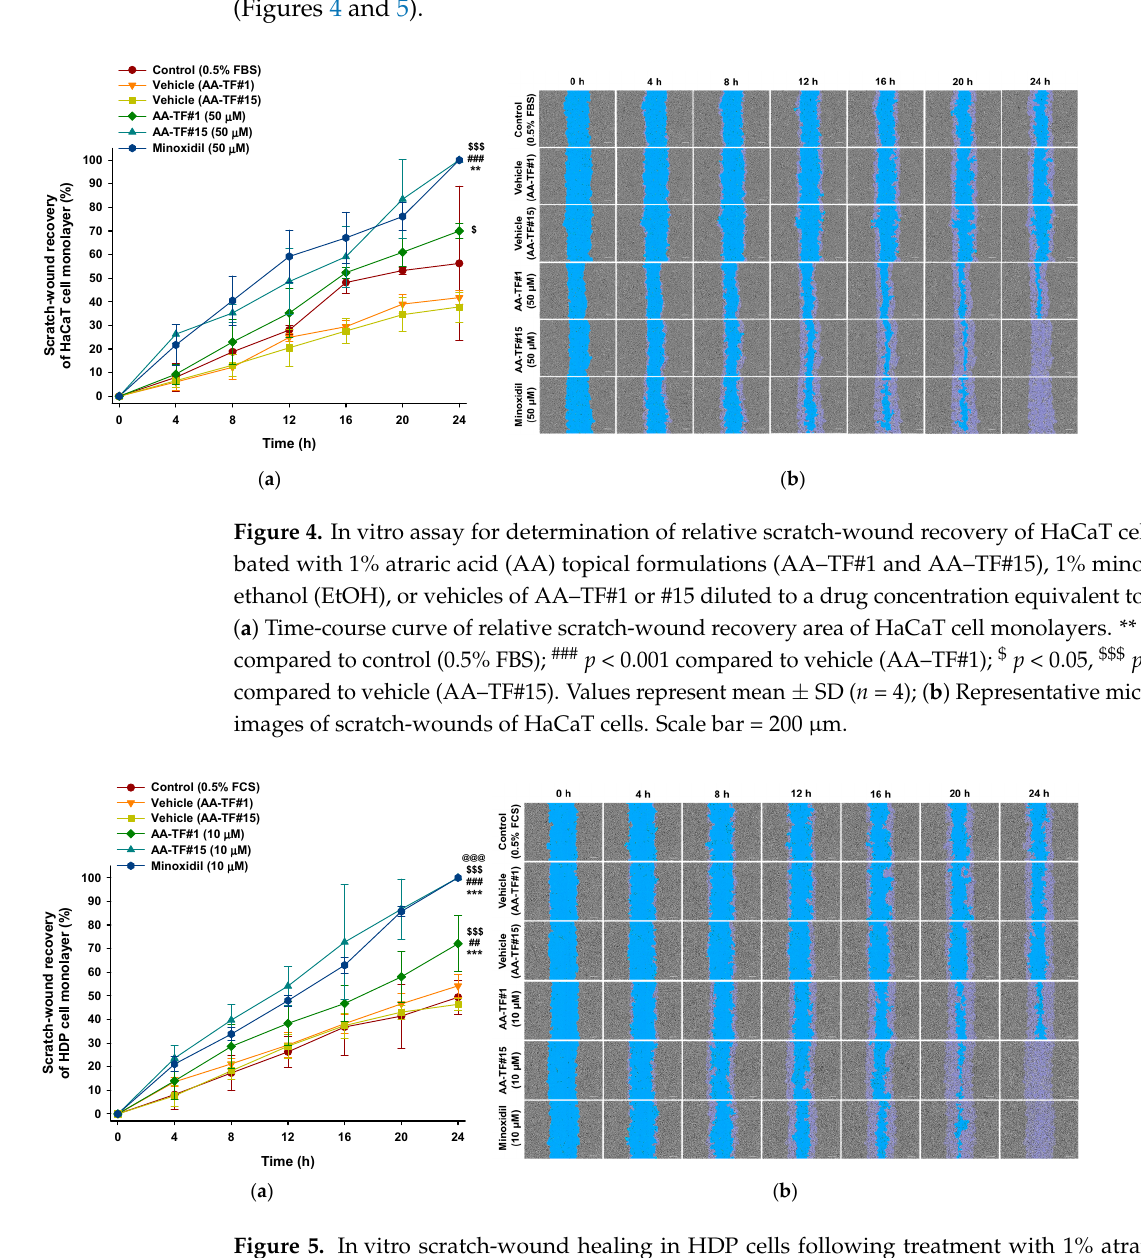
Figure 5. In vitro scratch-wound healing in HDP cells following treatment with 1% atraric acid (AA) topical formulations (AA–TF#1 and AA–TF#15), 1% minoxidil in ethanol (EtOH), or vehicles of AA– TF#1 or #15 diluted to a drug concentration equivalent to 10 µM: ( a ) Time-course showing relative scratch-wound recovery of HDP cell monolayer. *** p < 0.001 compared to control (0.5% FCS); ## p < 0.01, ### p < 0.001 compared to vehicle (AA–TF#1); $$$ p < 0.001 compared to vehicle (AA–TF#15); @@@ p < 0.001 compared to AA–TF#1 (10 µM). Values represent the mean ± SD ( n = 4); ( b ) Representative microscope images of HDP cell scratch-wounds. Scale bar = 200 µm. Hair growth was evaluated in alopecia mice after application with AA–TF#15. Dorsal